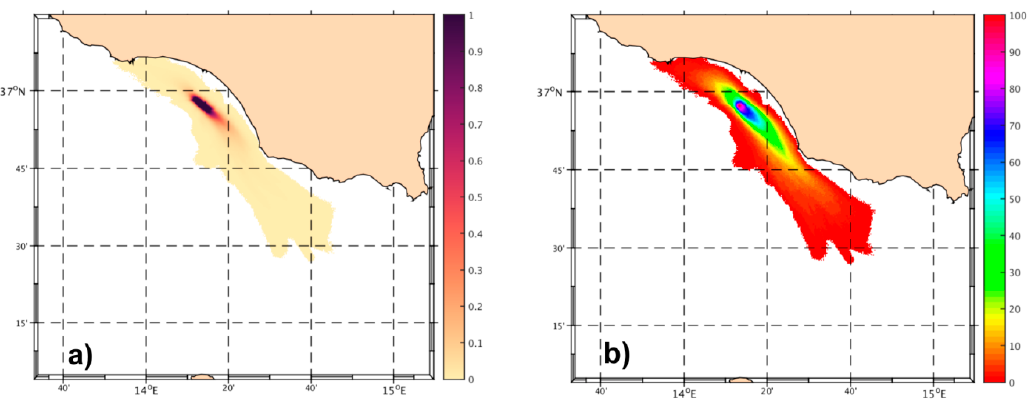
Figure Figure 8. The climatological annual calculation of ( a ) the hazard index (dimensionless) and ( b ) the occurrence probability index (percentage) related to the Perla platform.